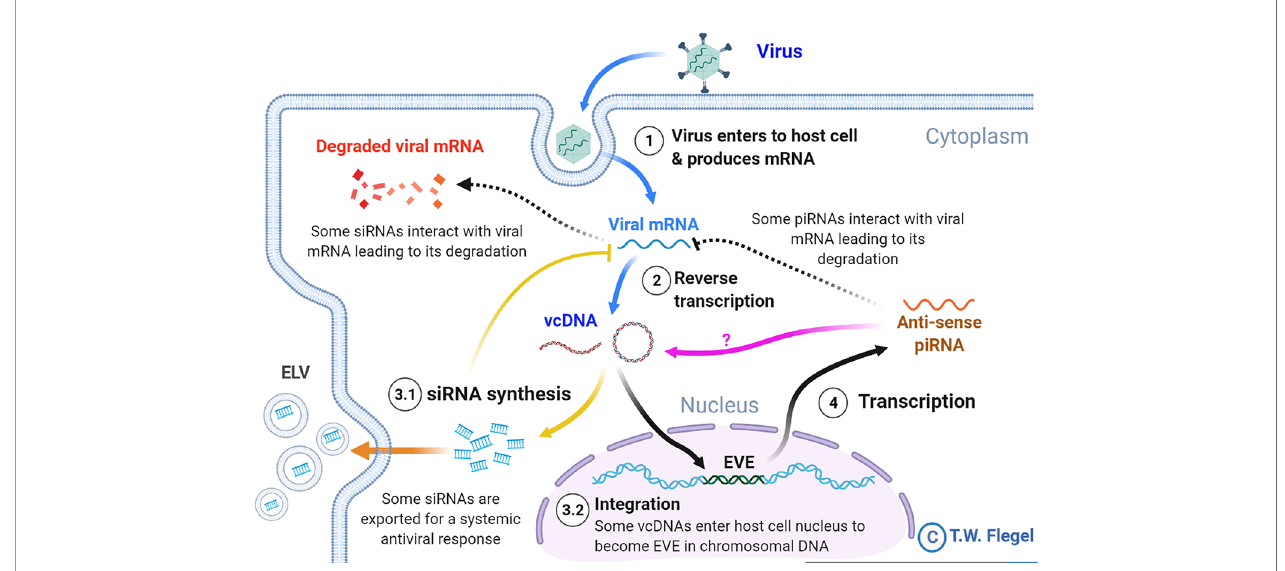
FIGURE 1 | A simpli fi ed diagram of the mechanisms involved in viral accommodation as updated from Flegel (5). The update includes additional pathways (indicated by yellow and orange arrows) that were not foreseen in the 2009 viral accommodation hypothesis (blue and black arrows). Speci fi cally, vcDNA was not predicted to occur also in a circular form (cvcDNA). In addition, no immediate production of siRNA leading to an RNAi response was predicted. Nor was the occurrence of exosome like vesicles (ELV) for systemic dispersal of the RNAi response predicted. Nor was the discovery (this paper) that EVE could produce viral circular DNA (purple arrow). All these features are hypothesized to occur in shrimp. Abbreviations used: siRNA for small interfering RNA and piRNA for PIWI-interacting RNA(s).